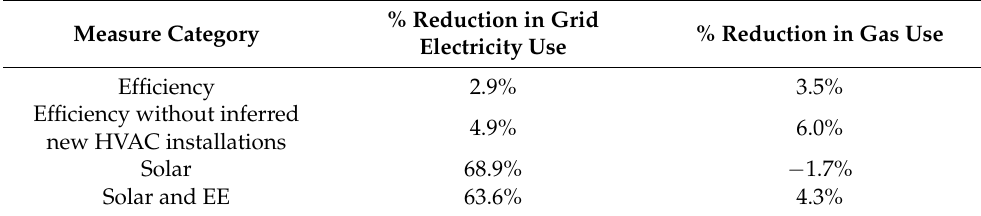
Table 4. Average reductions in grid electricity and gas use by type of project in California R-PACE